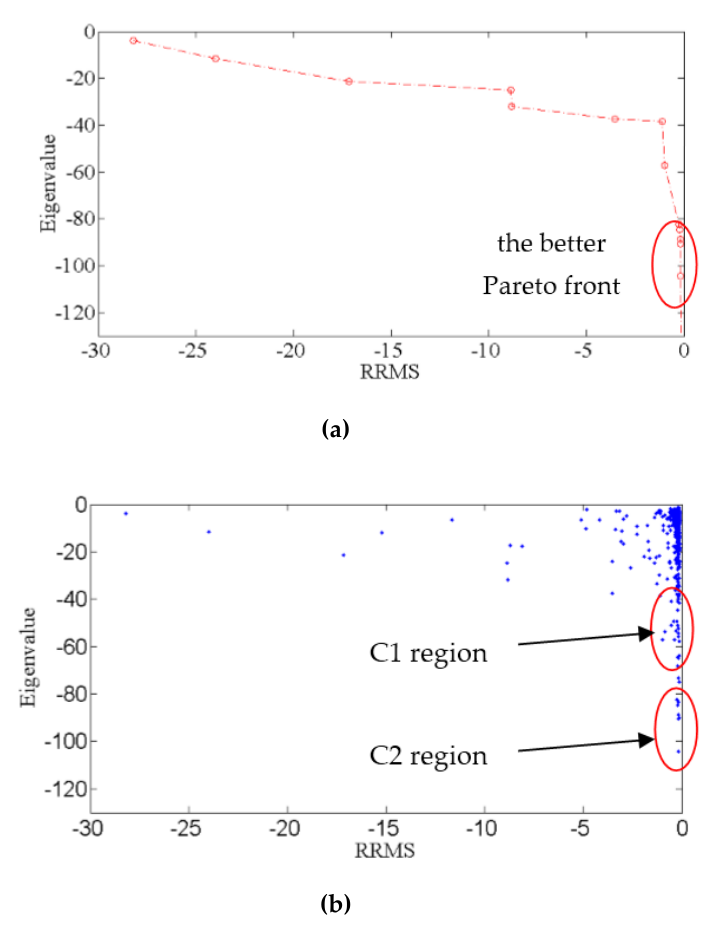
Figure 4. Optimal result: (a) Pareto front at the 100th iteration; (b) Objective function values of all positions visited by the swarm during optimization. Table 2. Optimized schemes of sensor distribution.